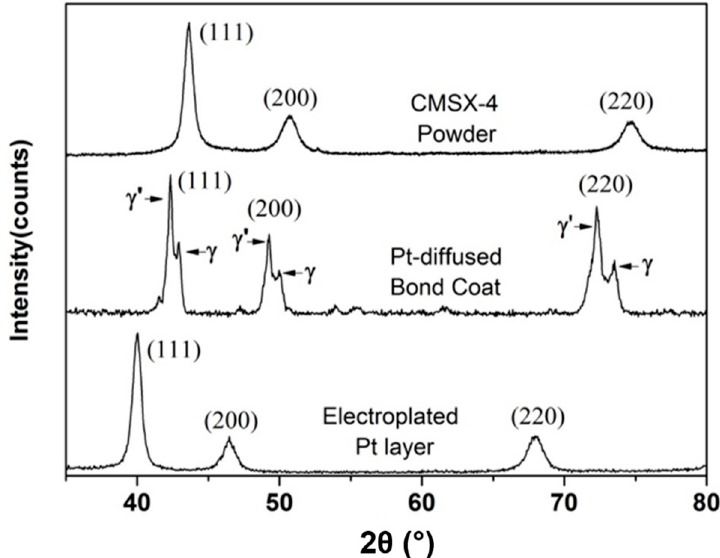
Figure 3. XRD patterns of (top) CMSX-4 powder ( γ ’-cubes); (middle) as-received Pt-diffused γ / γ ’ bond coat; and (bottom) as-electroplated Pt layer.